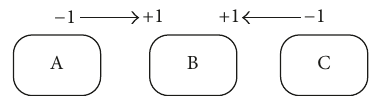
a +1 (if it empty) but that leaves open which neighbor is the sender. If it chooses one (by some rules), it must inform the neighbors so they will adjust their states